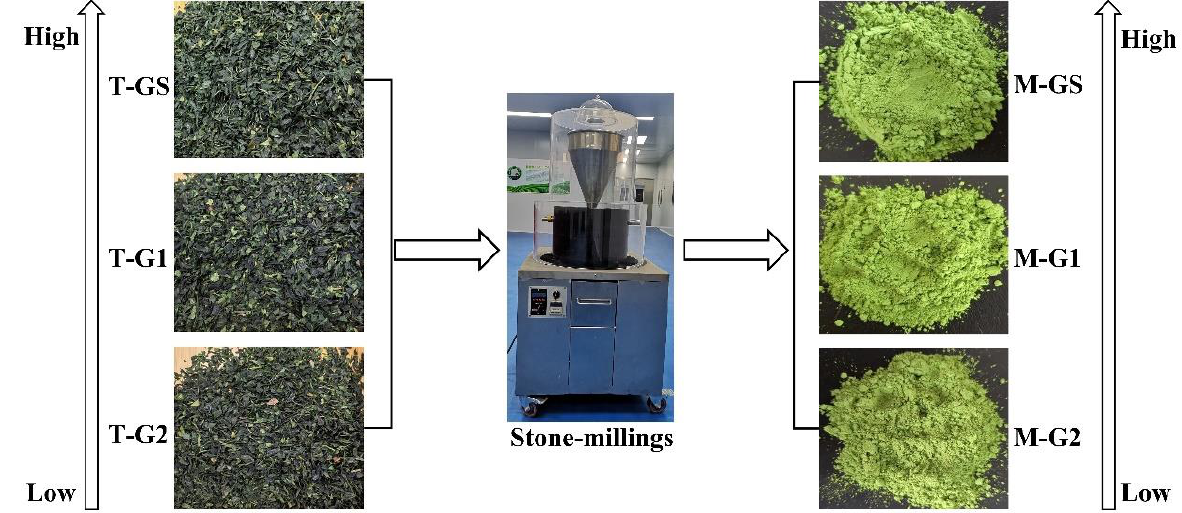
Figure 1. Processing flow chart of different grades of tencha and Shandong matcha.